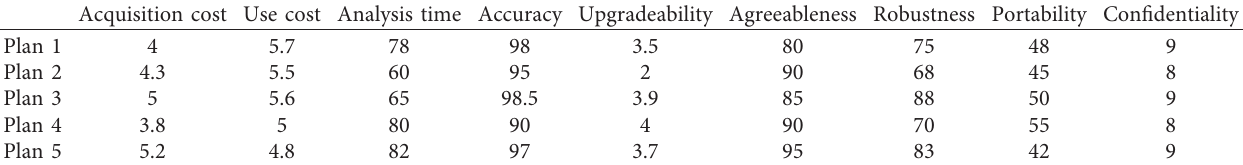
Table 4: The objective weight of the index is calculated by the entropy weight method.